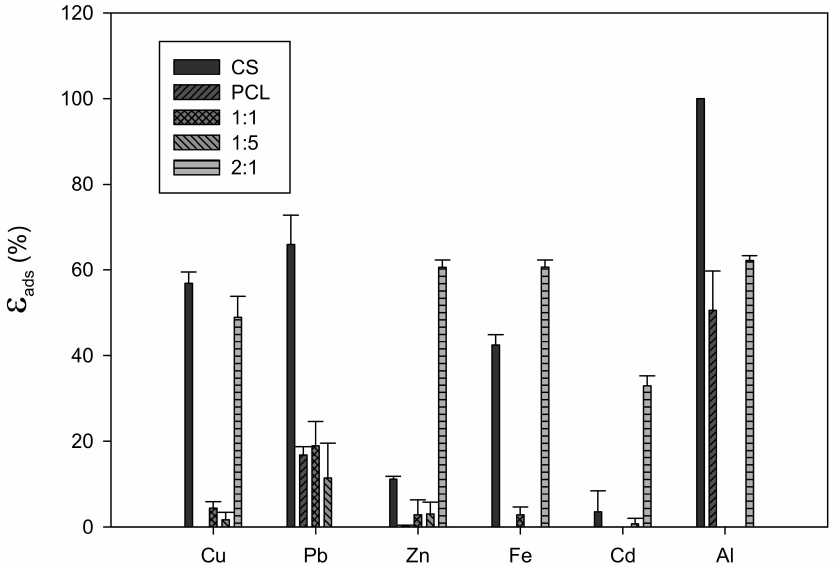
Figure A1. Heavy metal adsorption efficiency of the MCP